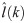
Illustration of likelihood approximation with a particle filter.A: Top: Likelihood for different parameters k (red) and contour lines of the joint distribution Π(k, log(k) of the parameter k and its likelihood approximation l^(k), based on 106 samples of the likelihood approximation obtained with a particle filter with 100 particles. Bottom: The constrained priors π(k|l(k) > ϵ) and π(k)p(l^(k)>ϵ|k) for ϵ = 1e − 24. B: Example distributions p(l^(k)|k) (blue) for k = 1, 1.2 and 1.4 and the true likelihood l(k) red.